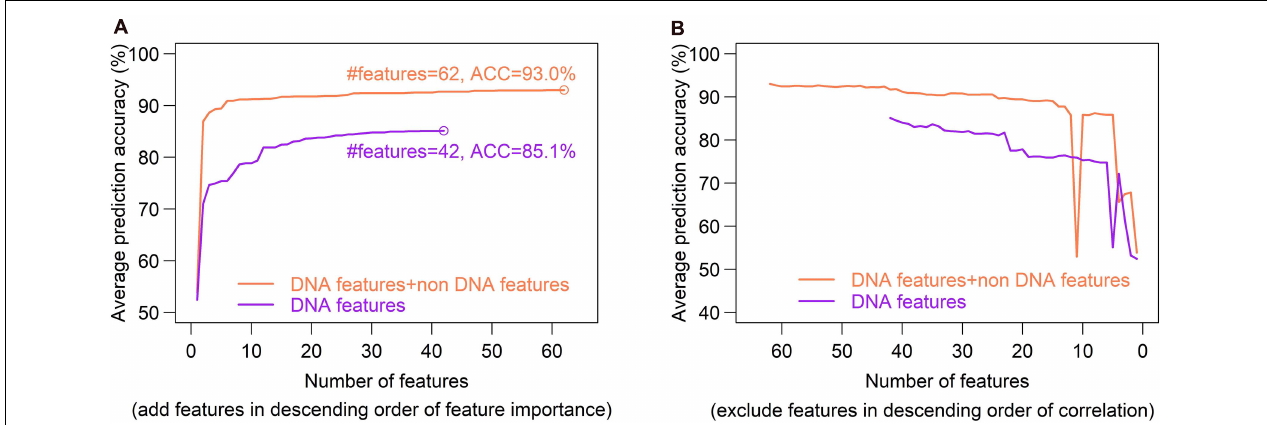
FIGURE 10 | Optimal set of DNA features is determined through a SVM-based Incremental Feature Selection method (IFS). (A) , In the IFS method, ANOVA was used to sort feature importance and then features were added one by one to feature space in the descending order of feature importance. For each turn of feature addition, SVM classifier was trained on the updated feature set, and average prediction accuracy of five-fold cross validation was reported. If the addition of a feature increases the average prediction accuracy, the feature was retained in the feature set, otherwise it was removed. Optimal sets were sought, respectively, in DNA-based feature space (DNA features) and the whole feature space (DNA features + non DNA features). Two optimal feature sets composed of 45 features and 44 features were obtained. (B) , Inter-correlated features were excluded sequentially from the feature sets obtained in figure (A) . During the feature-excluding process, no new peak was observed for prediction accuracy, and thus the optimal feature set determined through IFS remain